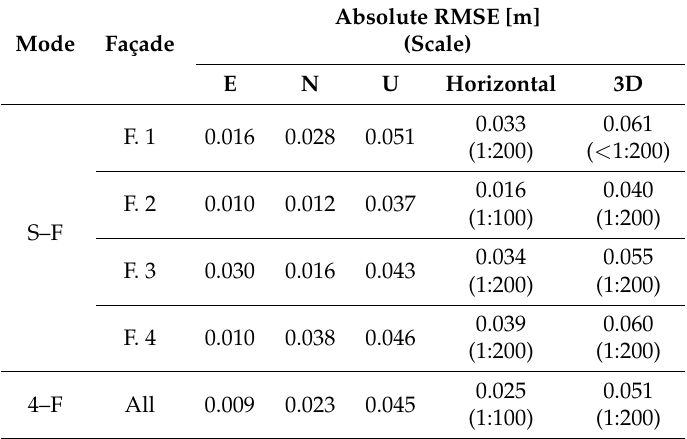
Table 8. Absolute RMSE–RTK dataset. The scale whose metric survey specifications were satisfied is also reported in